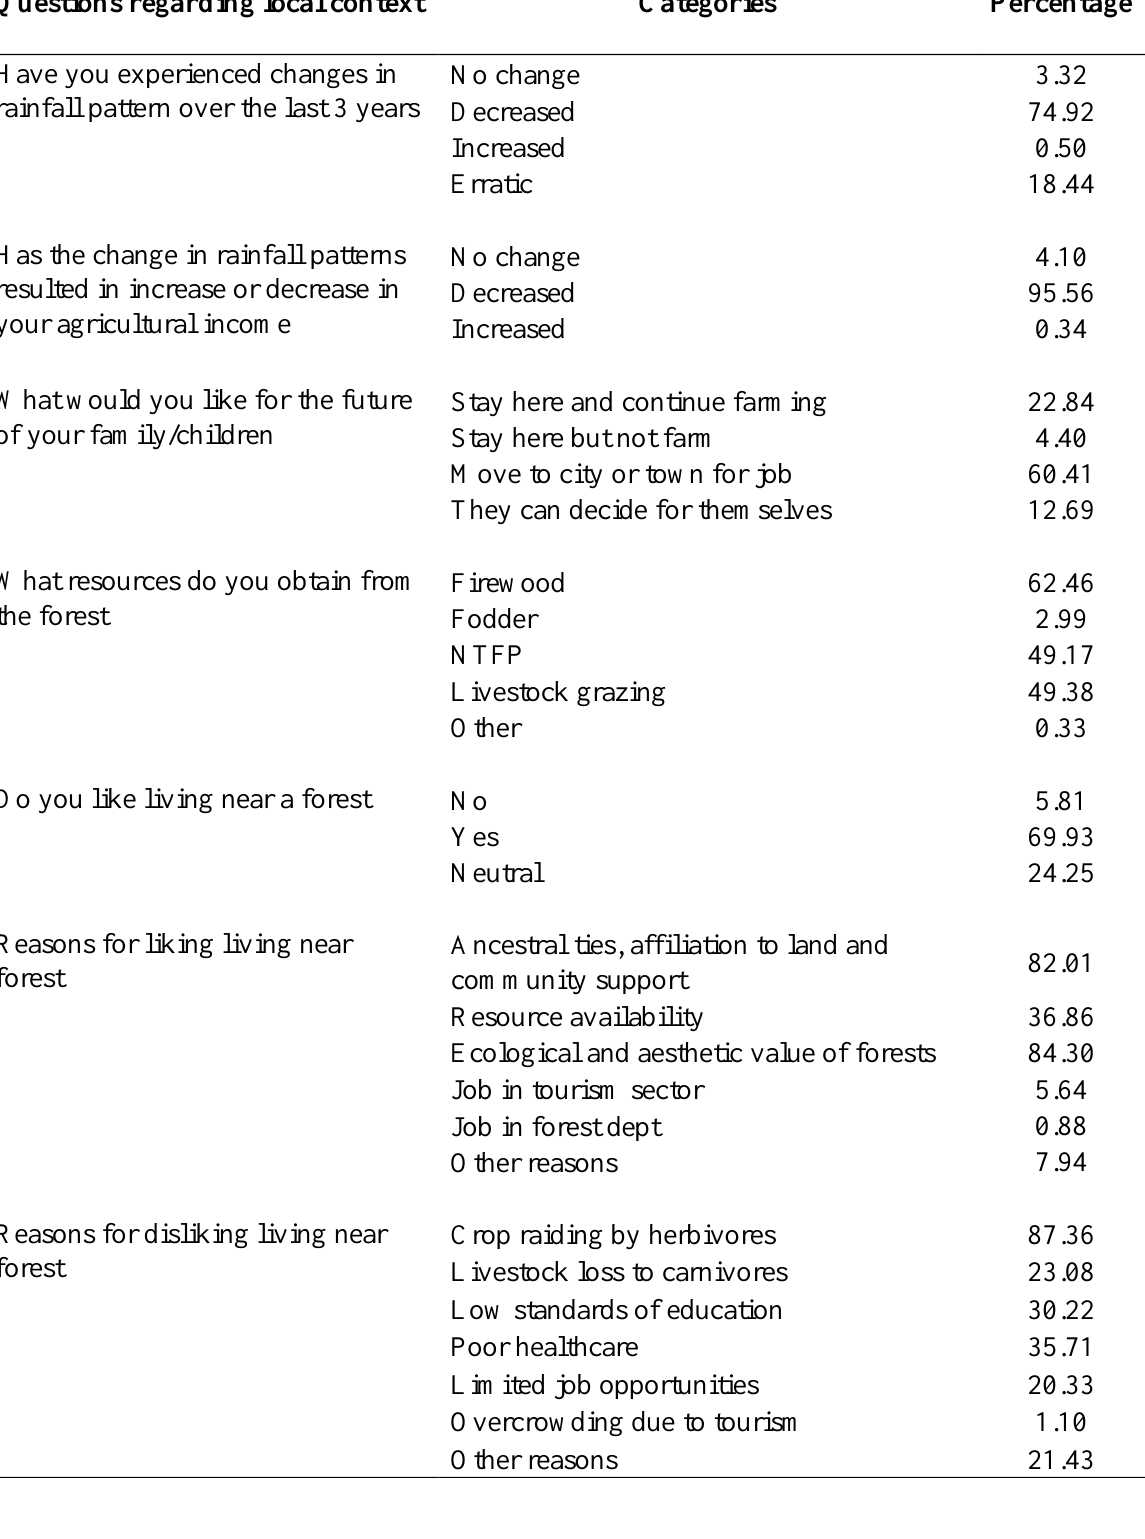
Table A1.3: Descriptive statistics for local context regarding rainfall trends, emigration, forest dependence, and perceptions about living adjacent to forest, based on questionnaire surveys (n = 602) in the buffer areas of Pench Tiger reserve, Madhya Pradesh,